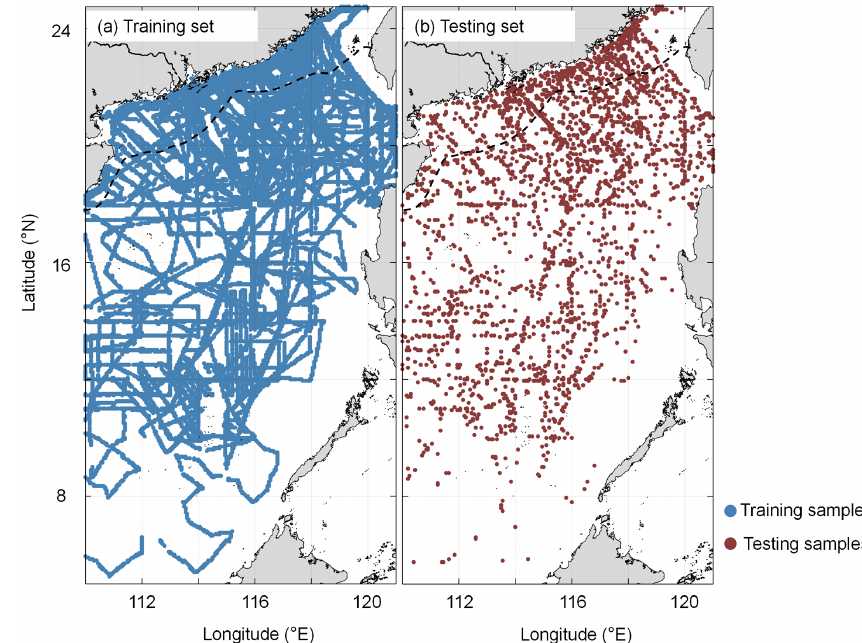
Figure 5. Spatial distributions of training samples (a) and testing samples (b) . The dashed black line shows the 200m